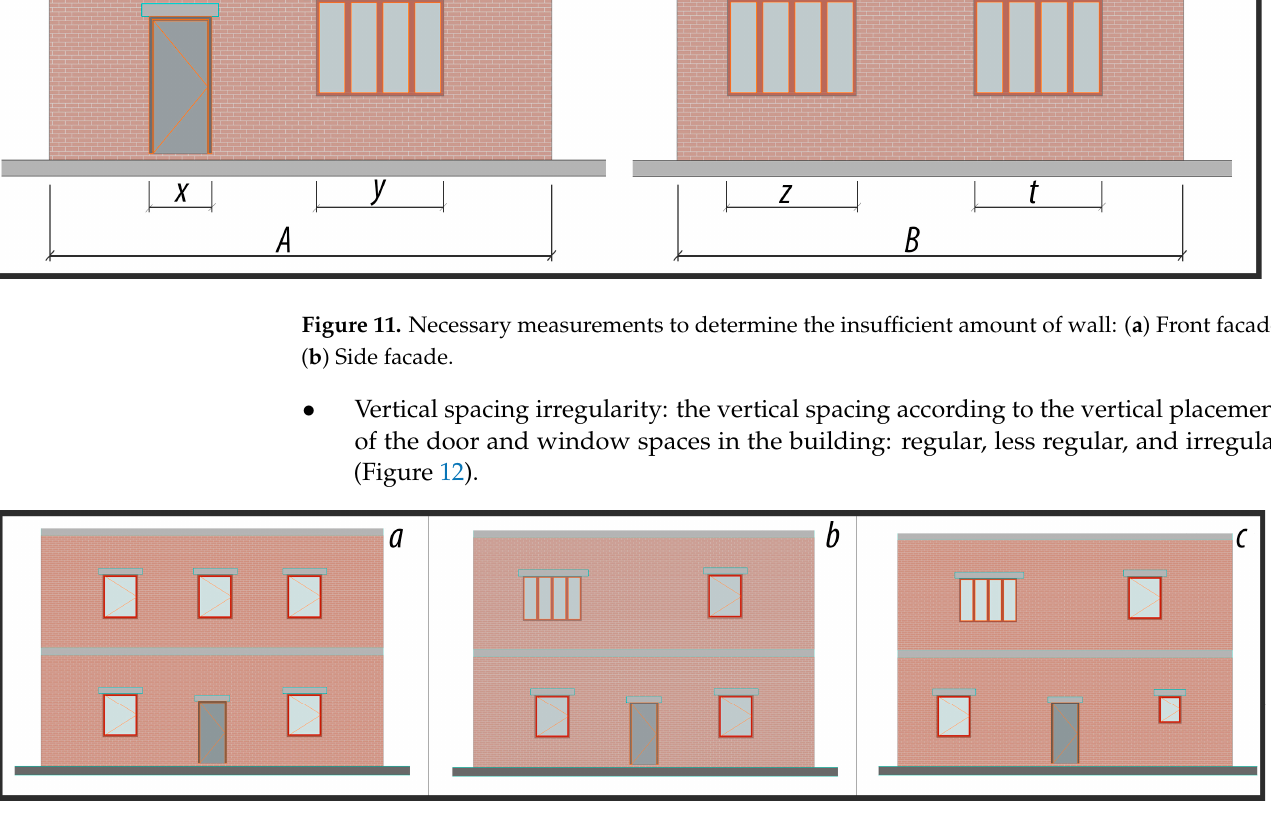
Figure 11. Necessary measurements to determine the insufficient amount of wall: ( a ) Front facade, ( b ) Side facade. Table 7. Parameters for calculating the wall quantity.